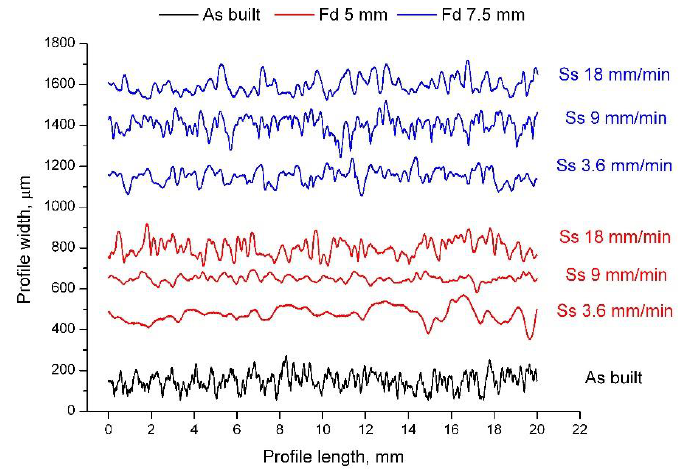
Figure 11. Surface profiles of as-built and treated samples.